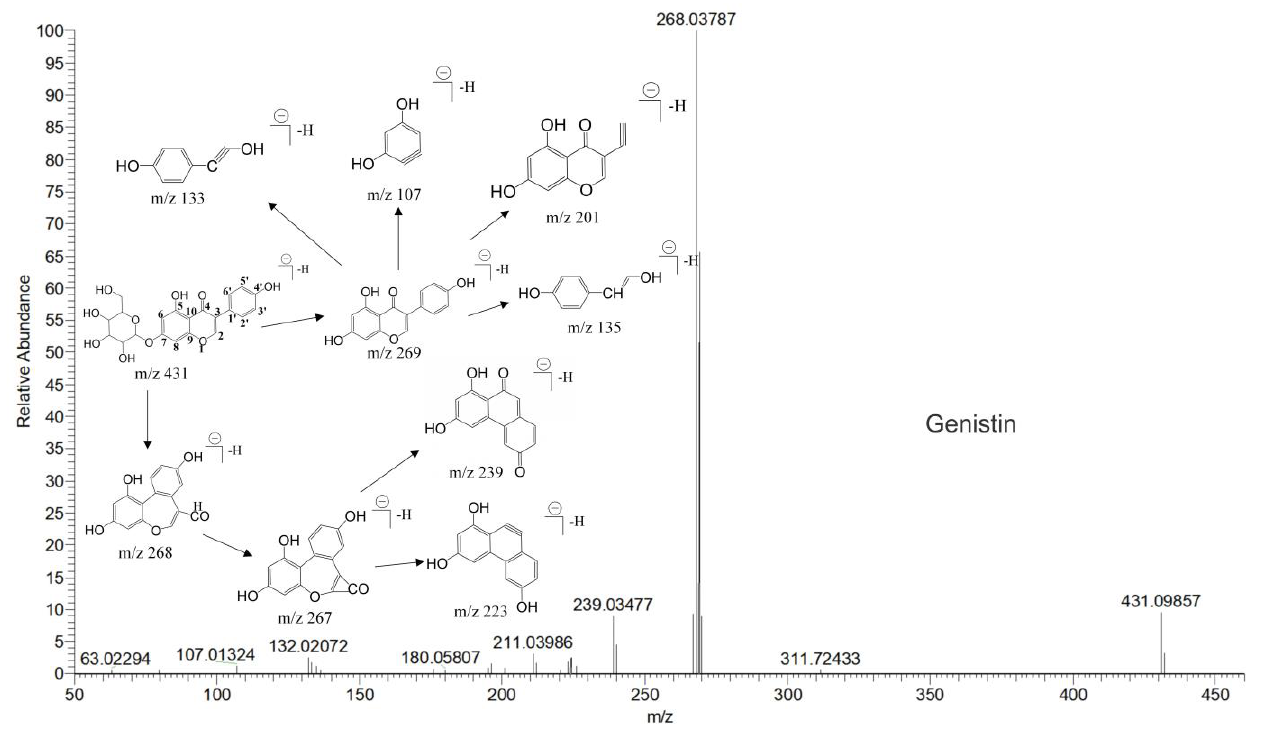
Figure 1. The metabolic profile of genistin.